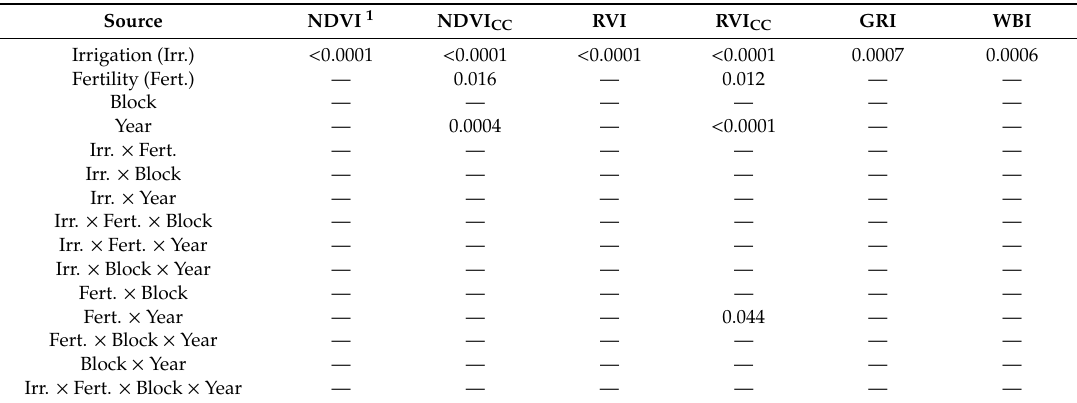
Table 3. Mixed model e ff ects p -values for spectral reflectance vegetation indices using a multispectral and hyperspectral radiometer for all dates of the trial. Source